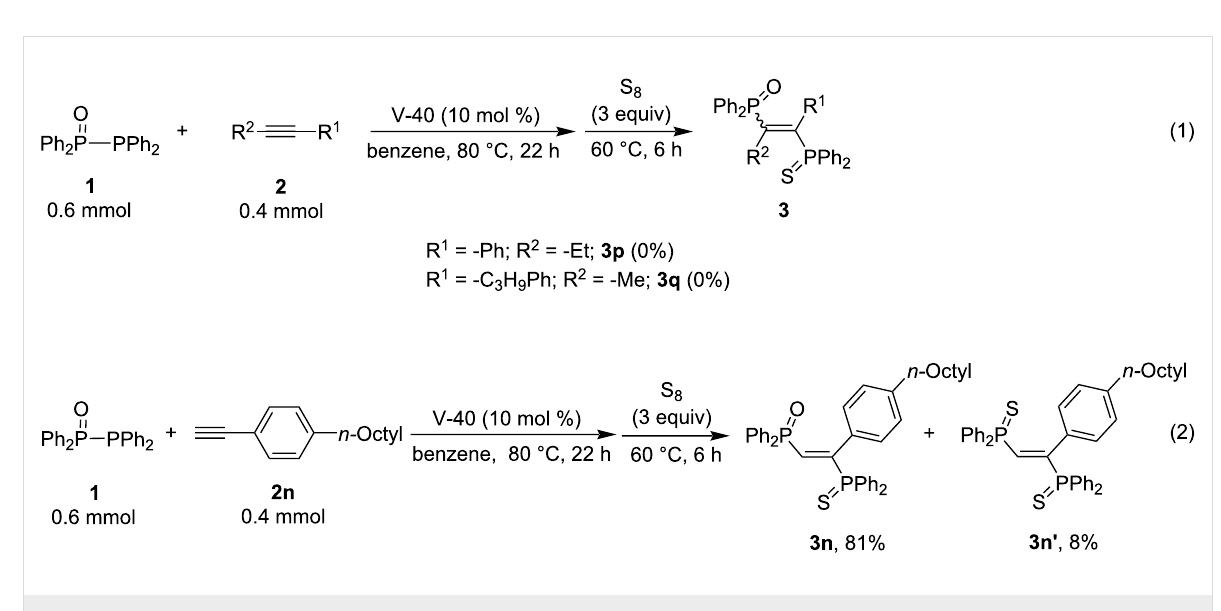
Scheme 4: Attempted radical addition to internal alkynes and insight into the addition to 2n